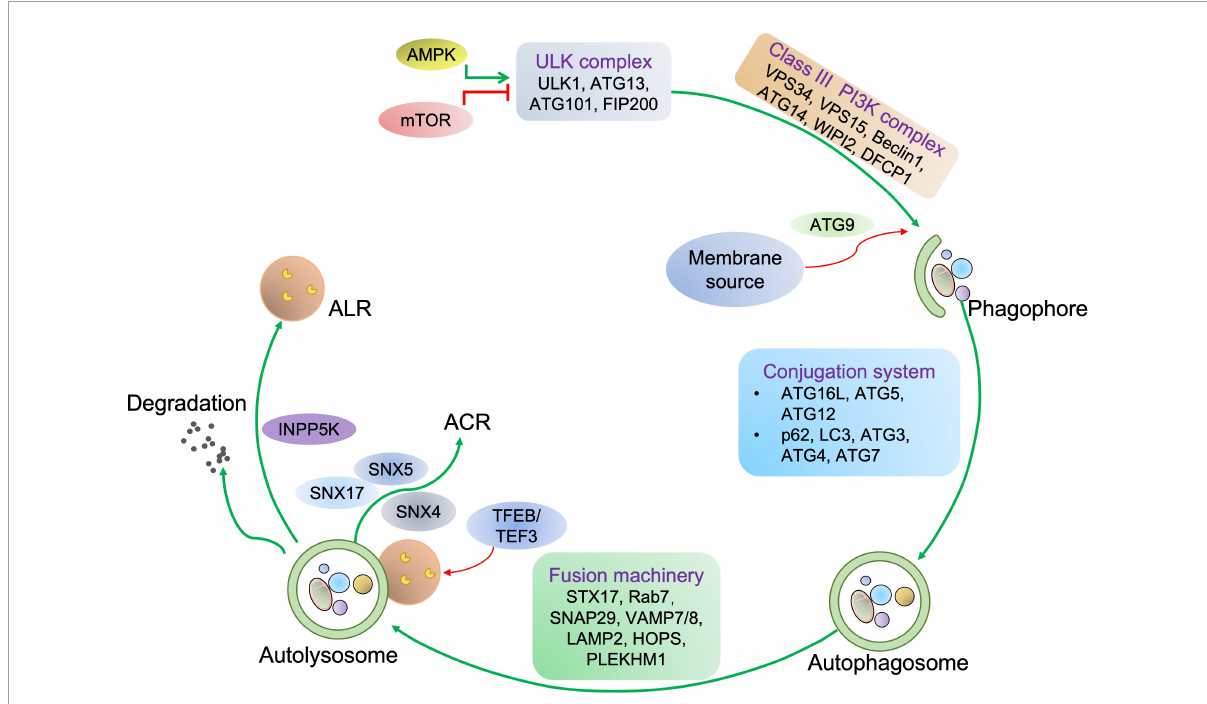
FIGURE1 Autophagy process in mammalian cells. For autophagy initiation, environmental factors and metabolic stimuli are sensed by AMPK or mTORC1. The autophagic cargo undergoes a serial of processes, including the phagophore and autophagosome formation, autolysosome development before the cargo is degraded, concomitant with lysosome and autophagosome recycling. Once autophagy is induced, ULK1 is activated and then associated with the class III PI3K complex, eliciting the production of PI3P on the phagophore membrane, which further recruits WD repeat domain phosphoinositide-interacting protein 2 (WIPI2) and double FYVE domain-containing protein 1 (DFCP1). Next, the ATG12-ATG5-ATG16L1 complex binding to WIPI2 is responsible for providing membranes from other organelles, including the plasma membrane, mitochondria, recycling endosomes, and Golgi complex. Then, ATG9 drives membrane expansion by delivering phospholipids. Moreover, the ATG12-ATG5-ATG16L1 complex promotes the conjugation of LC3, in which ATG4 cleaves LC3 to generate LC3-I, which further covalently bonds with phosphatidylethanolamine for LC3-II formation. LC3-II is a specific marker of autophagy where autophagosome-residing LC3-II can specifically associate with autophagy receptors with LC3-interacting motifs like p62. Finally, autophagosome-lysosome fusion is commonly mediated by UV radiation resistance-associated gene protein (UVRAG), homotypic fusion and protein sorting (HOPS), syntaxin-17 (STX17), vesicle-associated membrane protein 7/8 (VAMP7/8), synaptosome associated protein 29 (SNAP29), PLEKHM1, and the trafficking protein Rab-7. Concomitant with cargo removal, autophagosome effector proteins are either degraded or recycled by the Sorting Nexin 4/5/17 (SNX4/5/17) complex, and lysosomes maybe undergo the INPP5K-mediated ALR